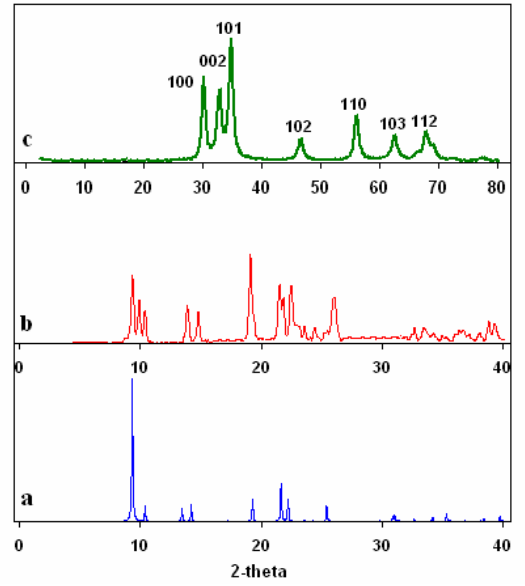
Fig. 4. XRD patterns; a) simulated pattern based on single crystal data of compound [Zn 4DMF· 1 ⁄ H O ( 2 ), b) white precipitate of 2 , c) ZnO 2 2 nanoparticles fabricated from calcination of compound 2 .